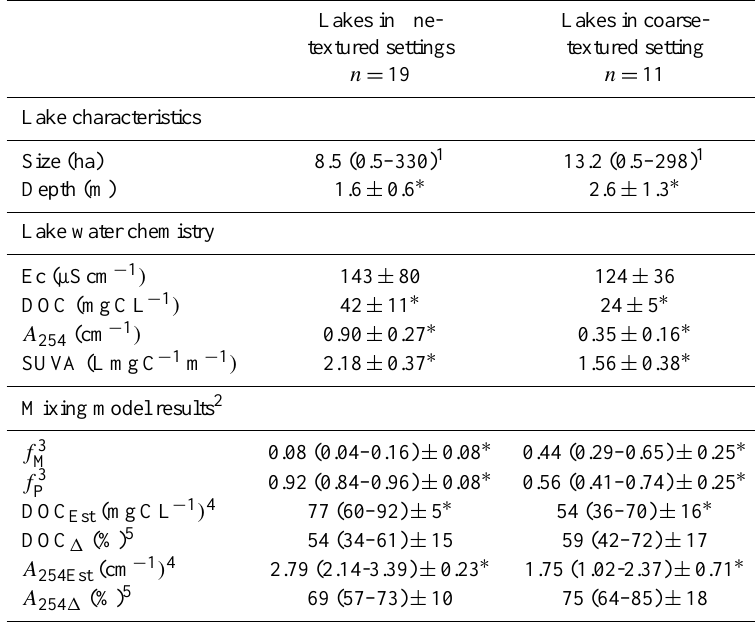
Table 1. Comparison of lake characteristics, water chemistry and mixing model results between lakes in fine- and coarse-textured settings. Averages ± 1 standard deviation reported unless otherwise